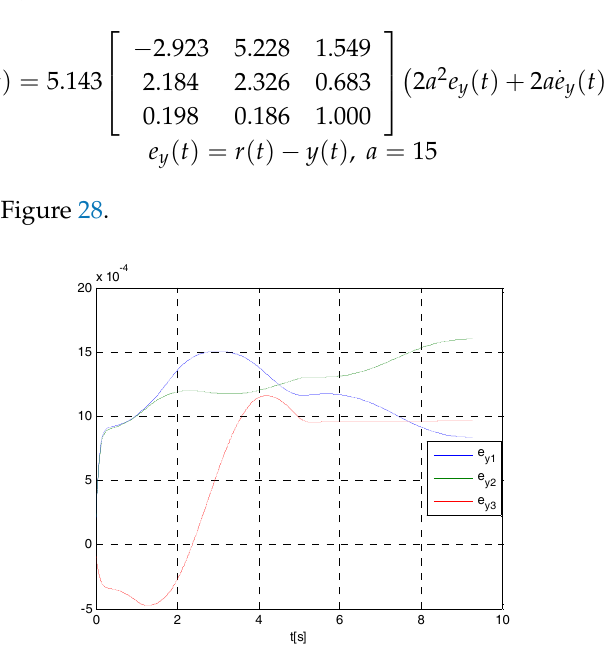
Figure 30. Virtual impedances: ( a ) spring-damper, ( b ) damper. Note that the output